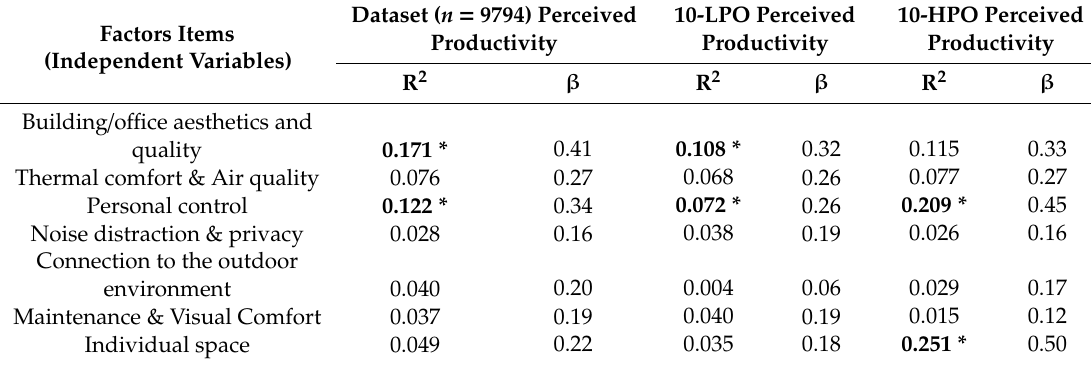
Table 5. Results of regression data analyses for 10-LPO and 10-HPO.